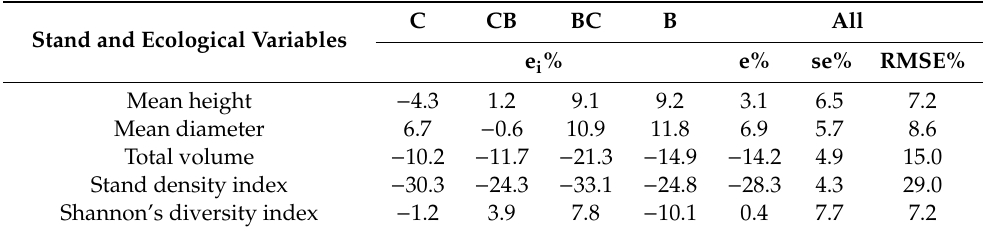
Table 4. Relative di ff erences between ALS-estimated and ground-measured data using the multisource-based method.